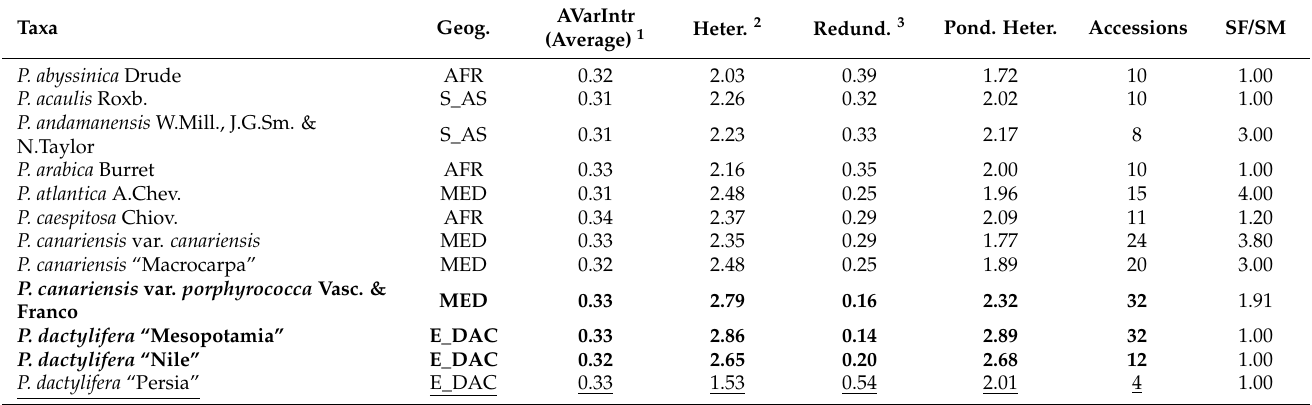
Figure 8. Probability distribution of the Phoenix intraindividual/intrapopulational variability. While the values of intraindividual/intrapopulational variability (including both female and male samples) within each of the populations or accessions analyzed present similar levels, of 0.33 ± 0.03, which represents a deviation of 9% from the mean value, the heterogeneity within the 43 OTUs, where each one is composed of four or more accessions, presents a greater variability of 2.25 ± 0.47 (Table 4), which represents a deviation from the mean above 20%. This suggests that the diversity or heterogeneity of each OTU depends to a great extent on the differences between accessions or localities there included and to a lesser extent on the intrapopulational variability. Table 4. Operative taxonomic units (OTUs), their intraindividual/intrapopulational morphological variability and morphological/taxonomic